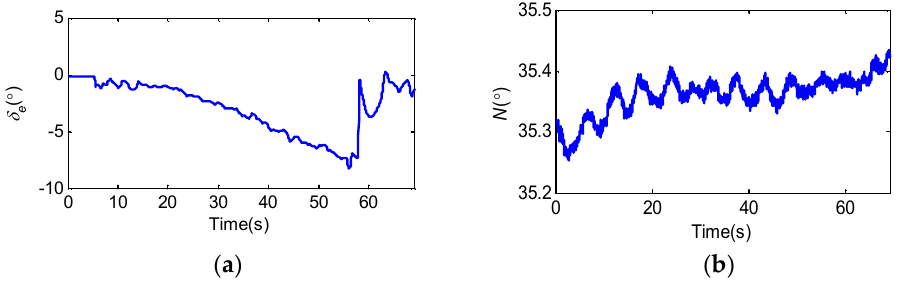
Figure A2. Flight test data of main control variables. ( a ) Deflection angle of elevator; ( b ) High- pressure rotor speed of engine.